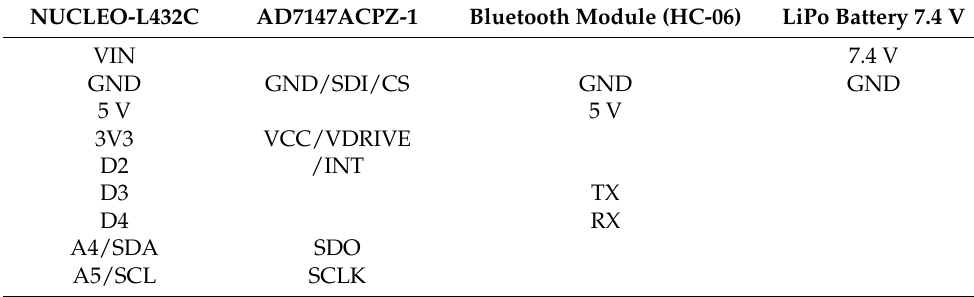
Table 2. PCB connectivity details. Each row represents a wire; if pin is written, it means that it is